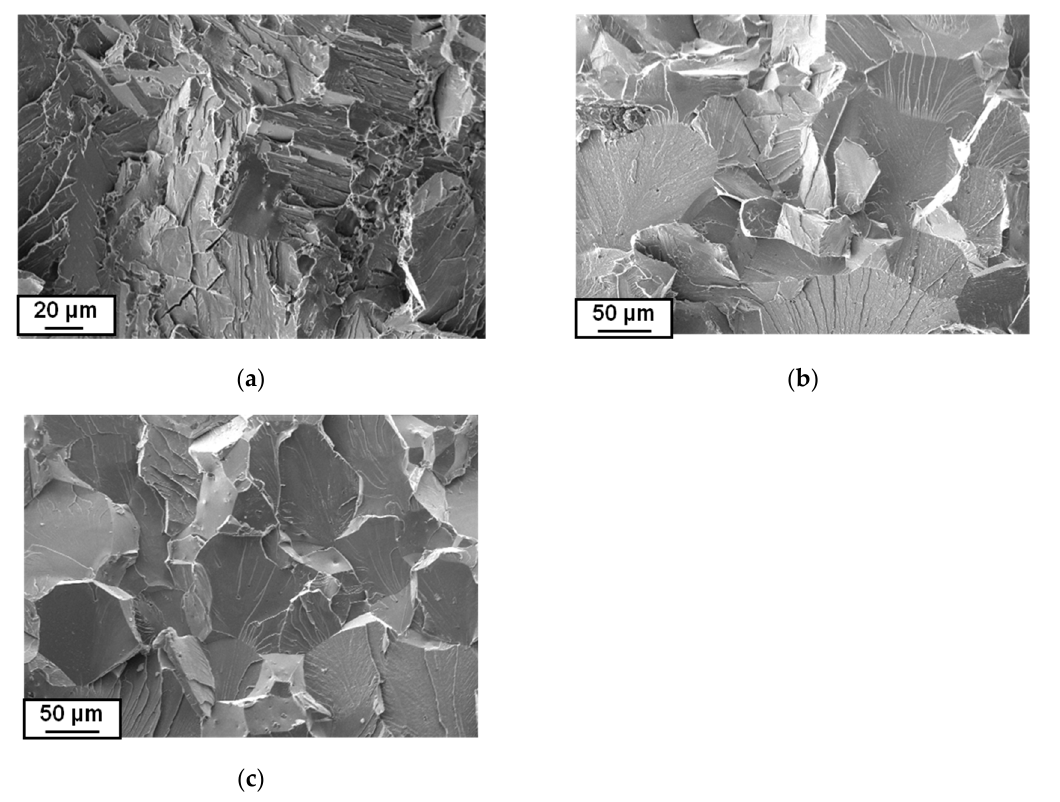
Figure 6. Fractures of samples after the three-point bending test, pre-deformed at 750 ◦ C ( a ), 800 ◦ C ( b ), and 850 ◦ C ( c